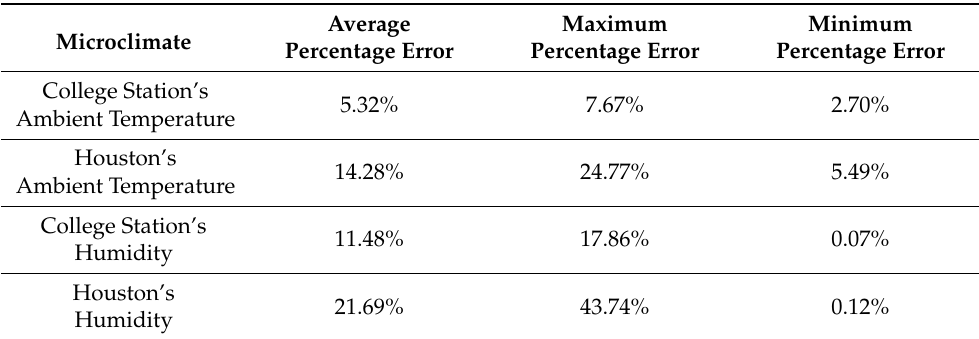
Table 1. Percentage error between the measurements from remote data station and the measurements from Weather Underground. Average Maximum Minimum Microclimate Percentage Error Percentage Error Percentage Error College Station’s 5.32% 7.67% 2.70% Ambient Temperature Houston’s 14.28% 24.77% 5.49% Ambient Temperature College Station’s 11.48% 17.86% 0.07% Humidity Houston’s 21.69% 43.74% Humidity